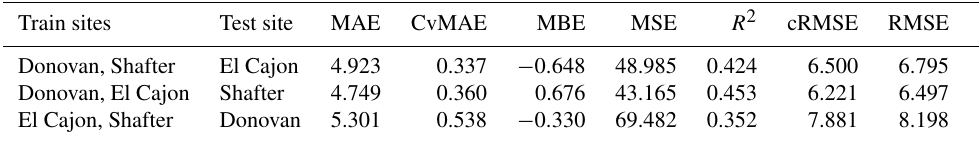
Table D6. Test results for split-NN Level 2, size 9 (NO 2 ).